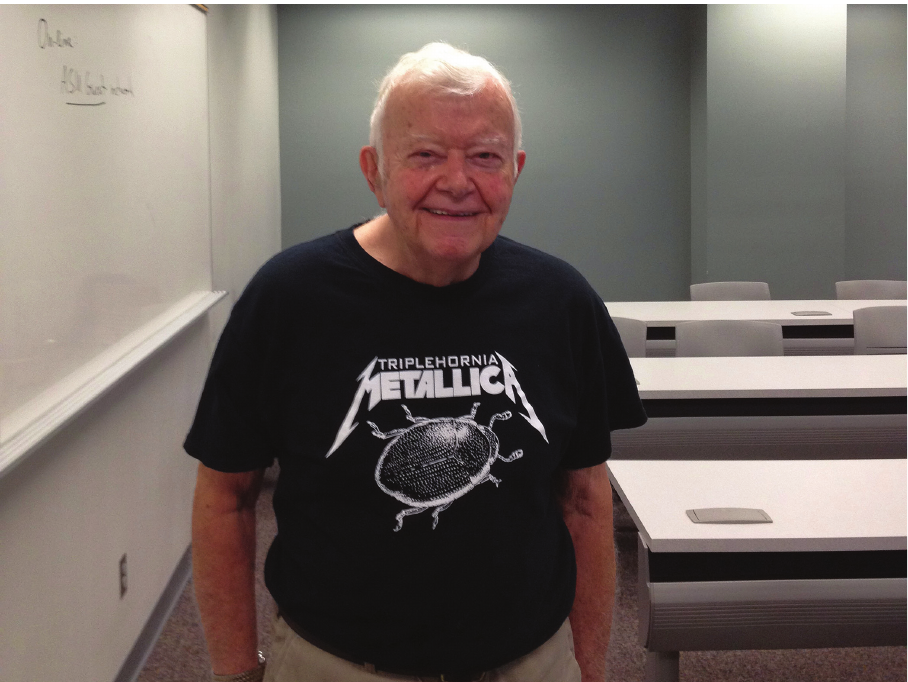
Figure 4. Dr. Charles A. Triplehorn showing off a Triplehornia metallica Matthews and Lawrence shirt made by his